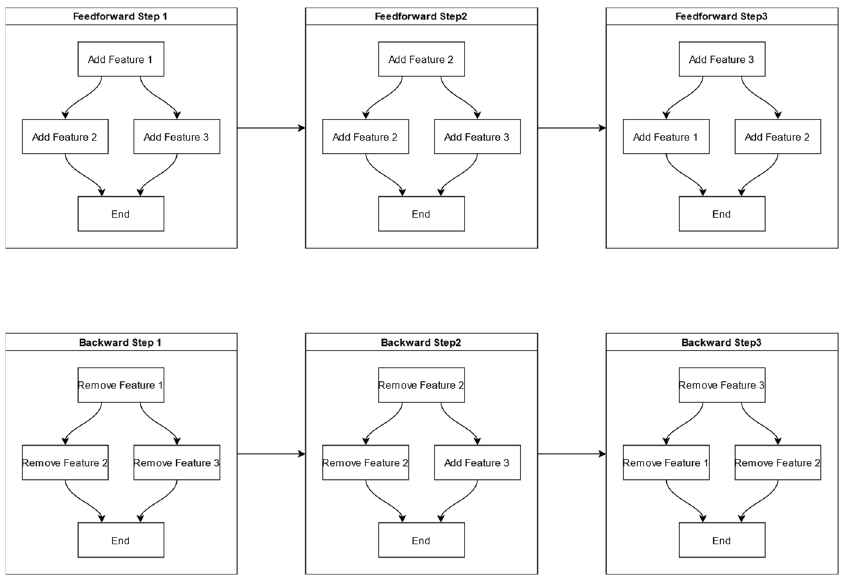
Figure 3. Flow diagram for feedforward and backward sequential feature